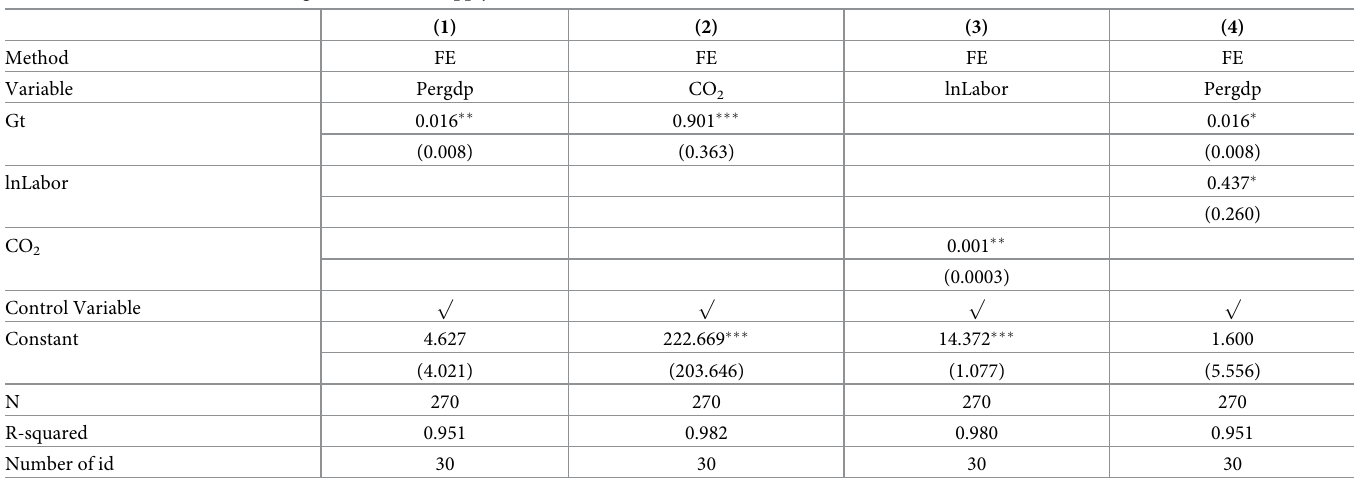
Table 7. Estimation of the mediating effect of labor supply at the national